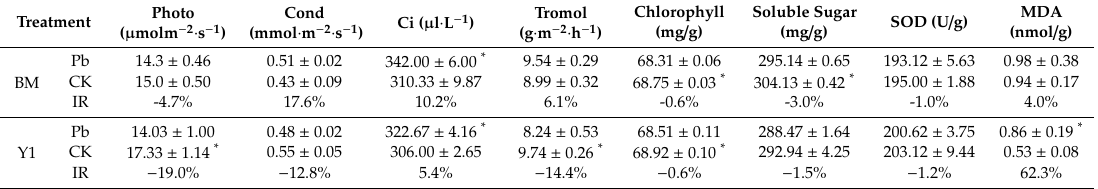
Table 1. Physiological indicators of two hemp varieties under Pb